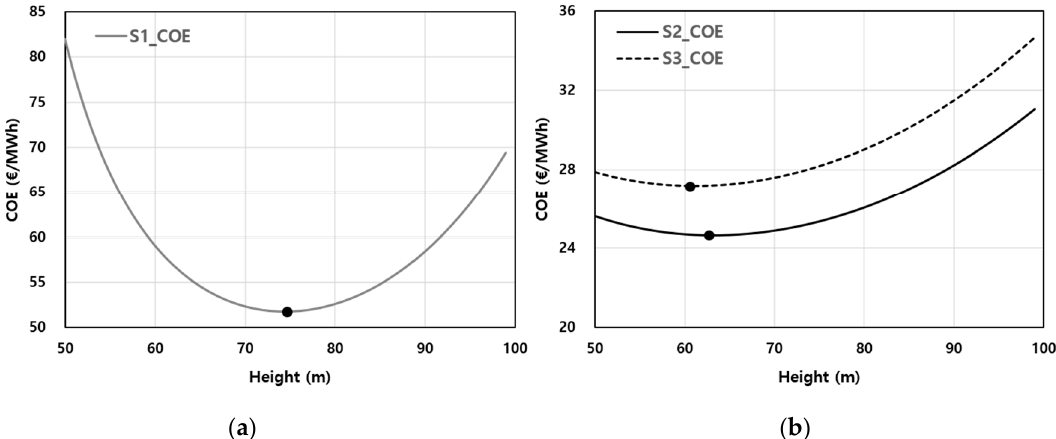
Figure 5. Distribution of optimal hub height for WT0.